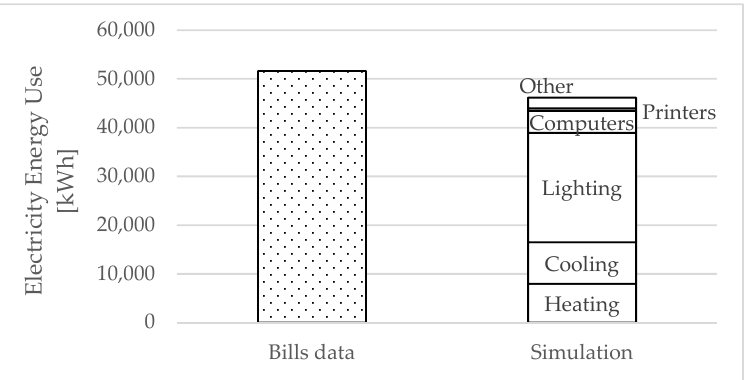
Figure 9. Validation of the simulation, annual data.